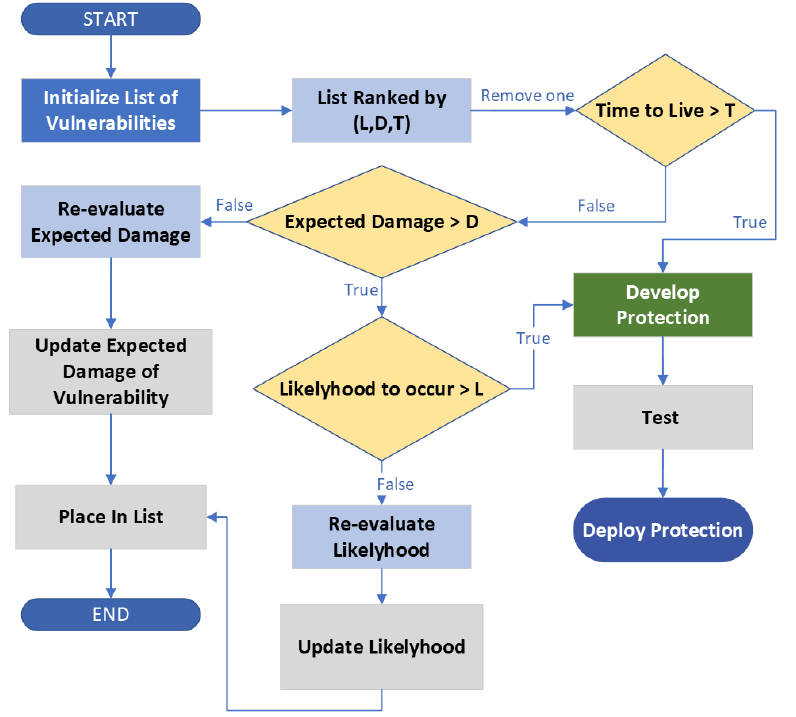
Figure 8. Cybersecurity development process for protecting IT (iterated at minimum acceptable